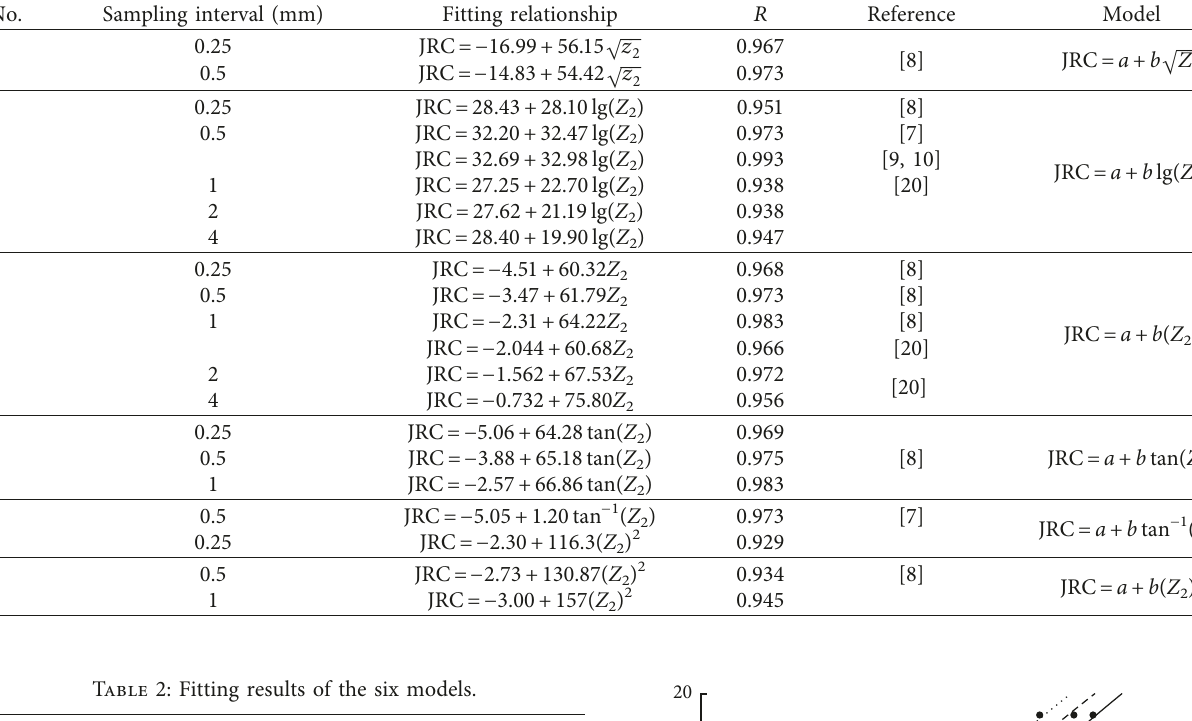
Table 1: Relationship between JRC and Z